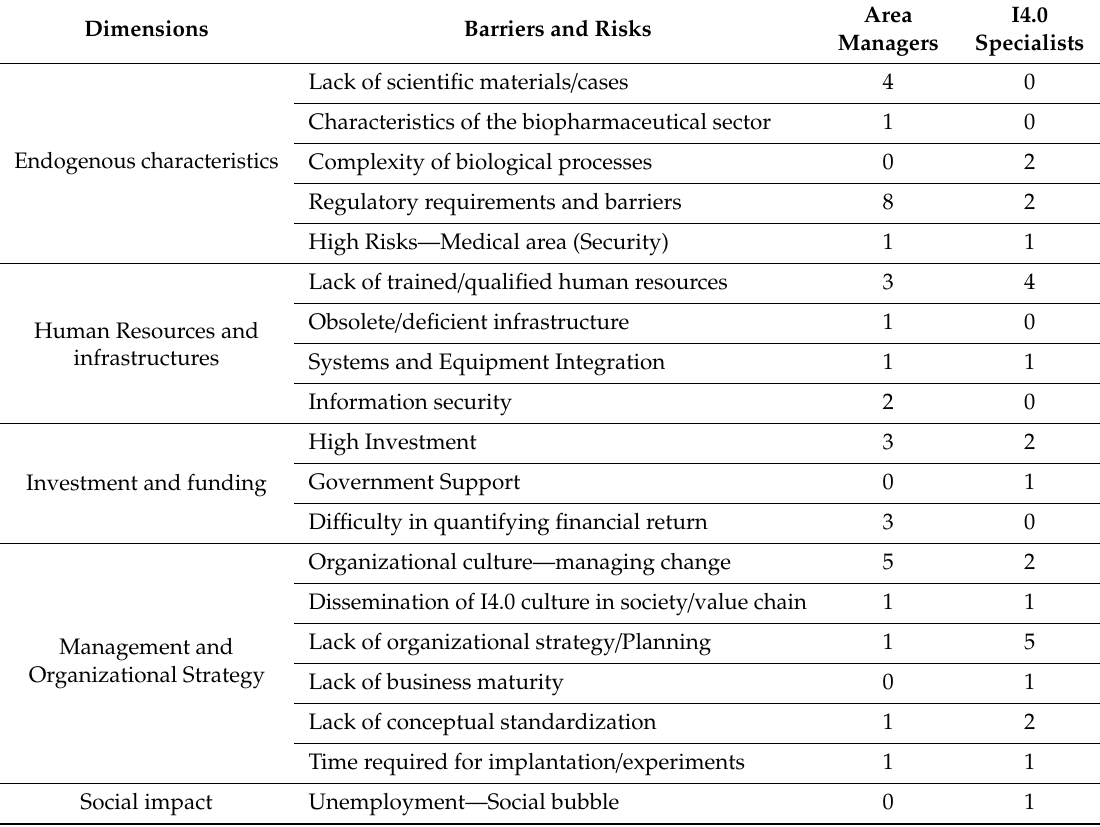
Table 4. Barriers and Risks punctuated by category of respondents considering the established dimensions.